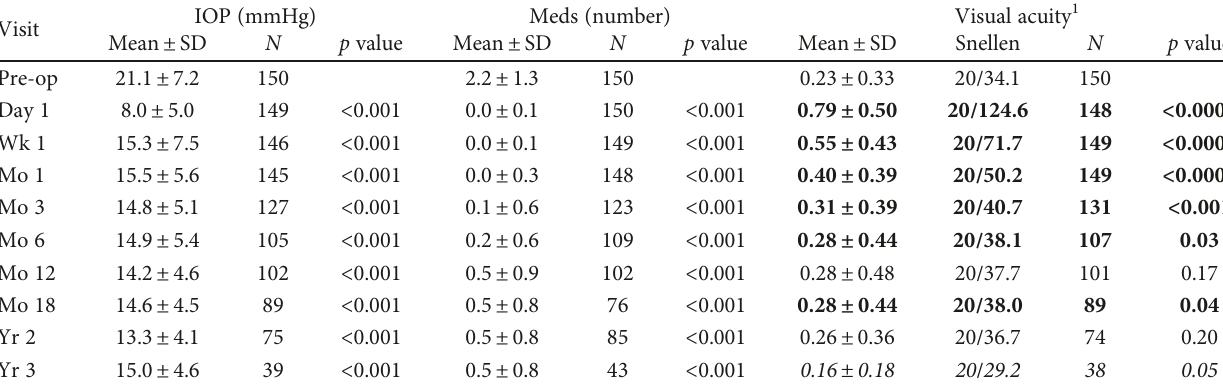
Table 3: Outcome measurements by visit (eyes with canaloplasty